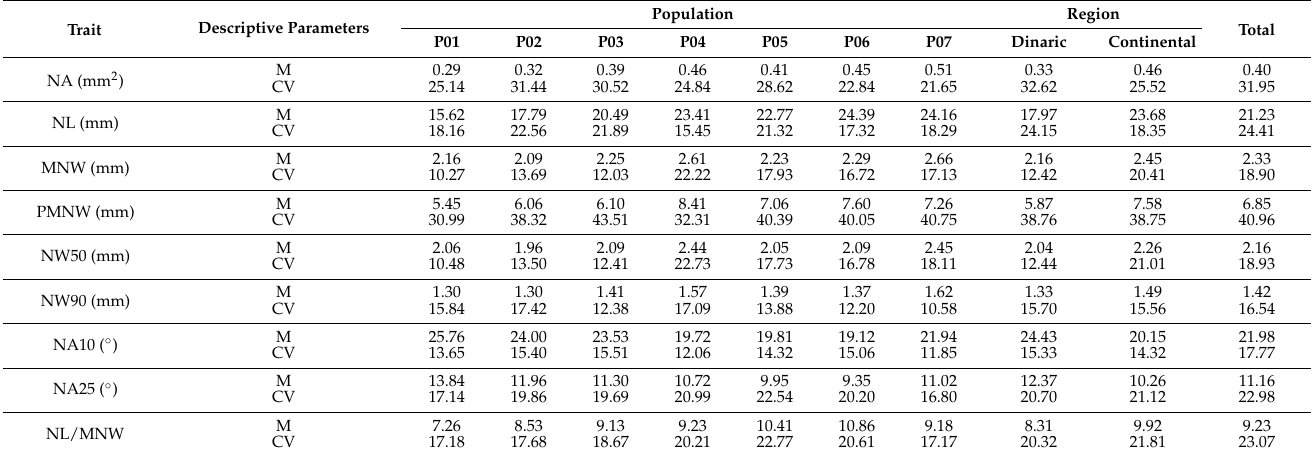
Table 1. Results of the descriptive statistical analysis for studied populations and morphometric traits. Morphometric traits analysed: needle area (NA); needle length measured from the base of the needle up to the tip, along the central vein (NL); maximum needle width (MNW); needle length, measured from base to the widest point of needle (PMNW); needle width at 50% (NW50) and 90% (NW90) of needle length; angle enclosed by the main vein and line between needle base and point on the 10% (NA10) and 25% (NA25) of needle length; for needle shape, needle length/maximum needle width ratio (NL/MNW). Descriptive parameters: M—arithmetic mean; CV—coefficient